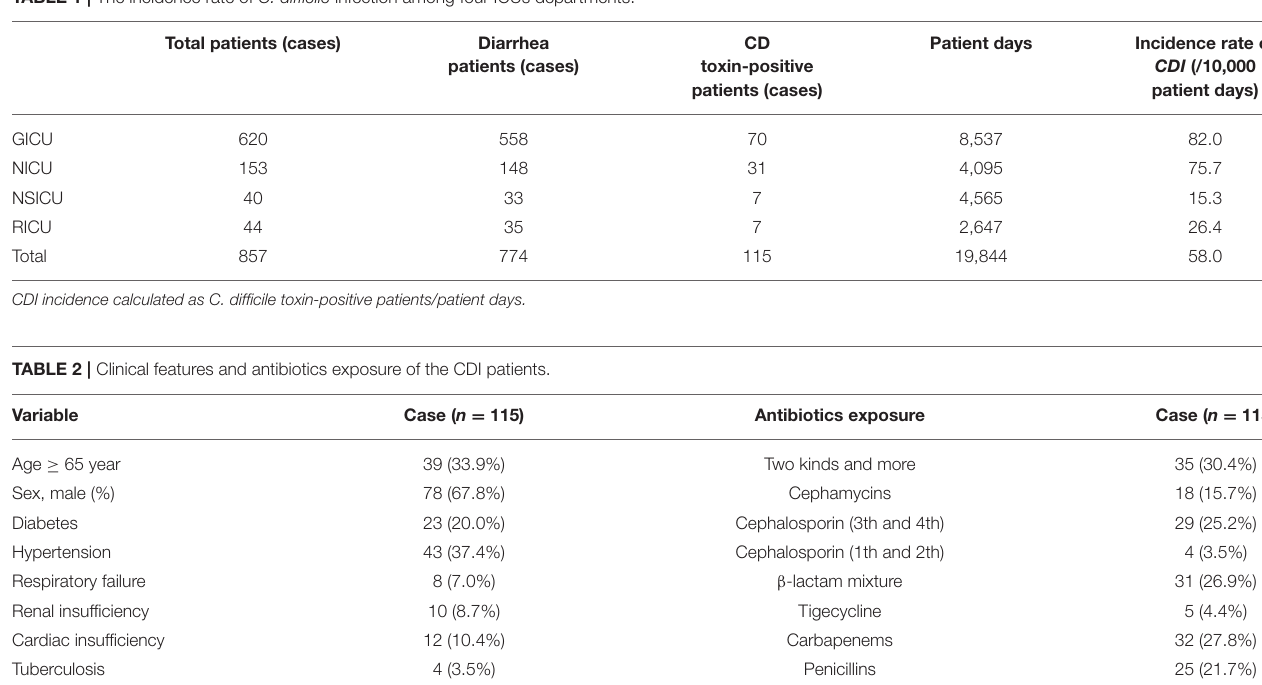
TABLE 1 | The incidence rate of C. difficile infection among four ICUs departments.